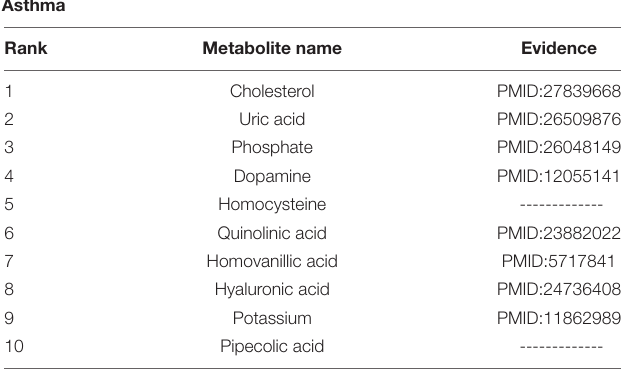
TABLE 3 | Candidate metabolites of